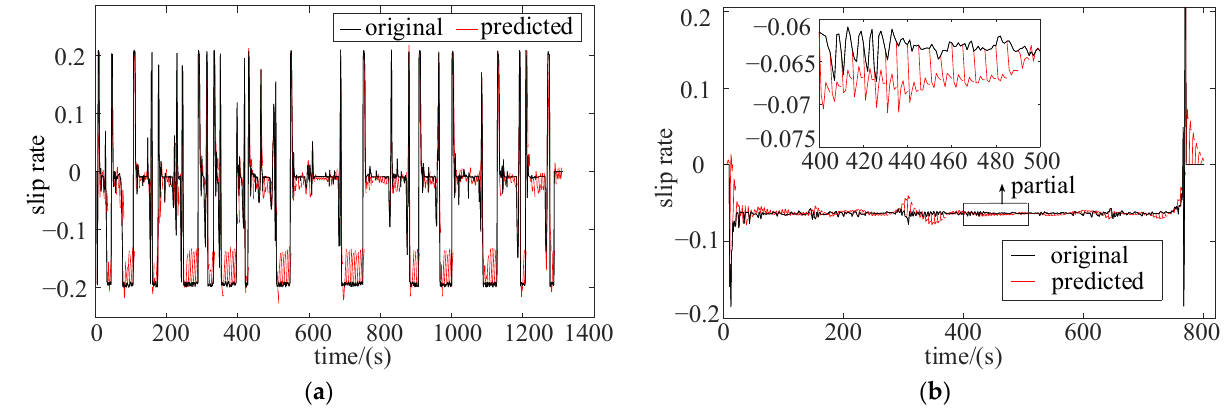
Figure 16. Slip ratio prediction results. ( a ) UDDS; ( b ) HWFET. (single pavement).